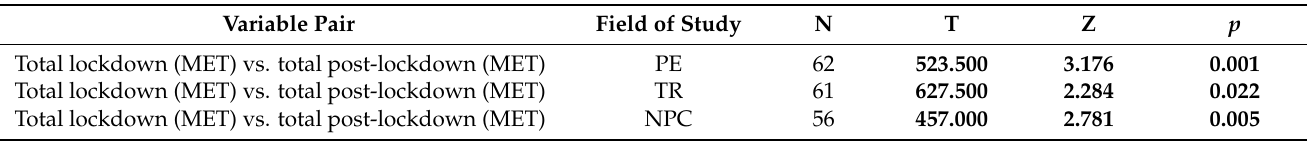
Table 3. Comparison of physical activity (MET) of students in MET in the lockdown and post- lockdown period (Wilcoxon’s signed-rank test).